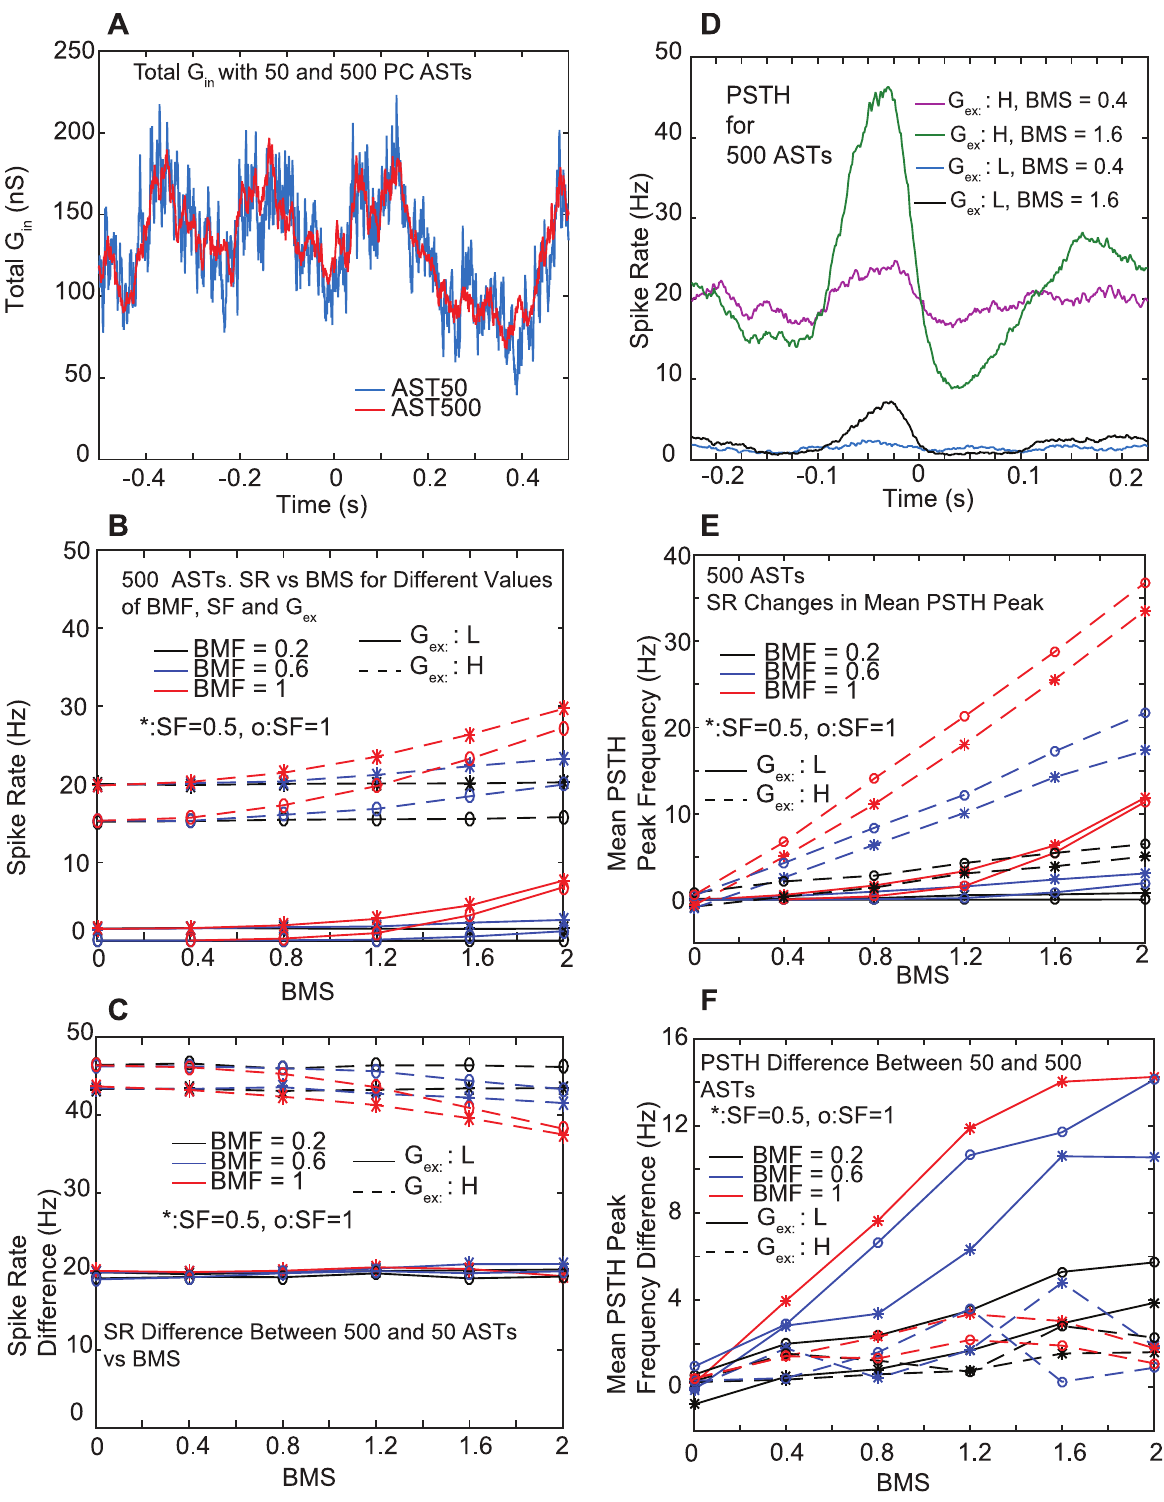
Fig 7. Comparison of CN simulations with 500 vs. 50 PC AST inputs. A. The unitary conductancewas dividedby 10 for 500 inputs to result in a matchingmean inhibitoryinput conductance. B,D,E. Conventionsas in Fig 6. C. The 500 PC inputs lead to a much reducedspike rate. F. Differencebetween(E) and Fig 6B. PSTH mean peak frequency changesare generallysimilar, but higherby up to 14 Hz for G ex : L with 50 PC inputs.